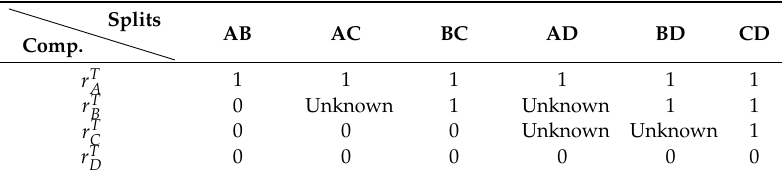
Table 1. Recovery matrix describing different splits for the separation of a four components mixture containing ABCD.